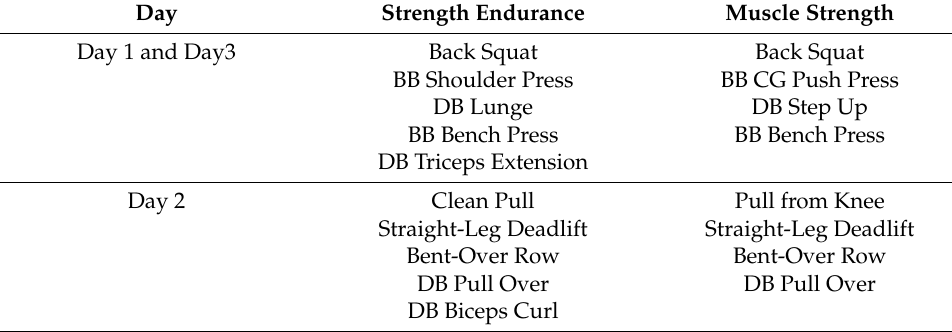
Table 3. Exercise selection for strength training